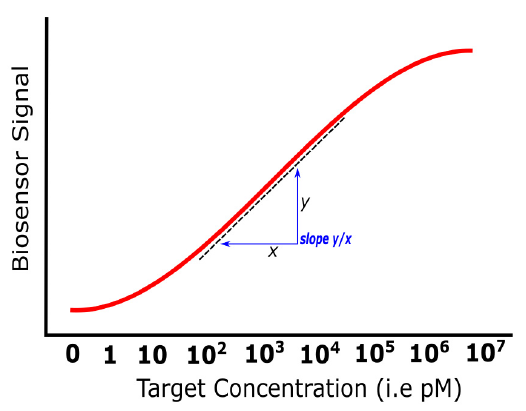
Figure 6. The illustration of sensitivity performance in